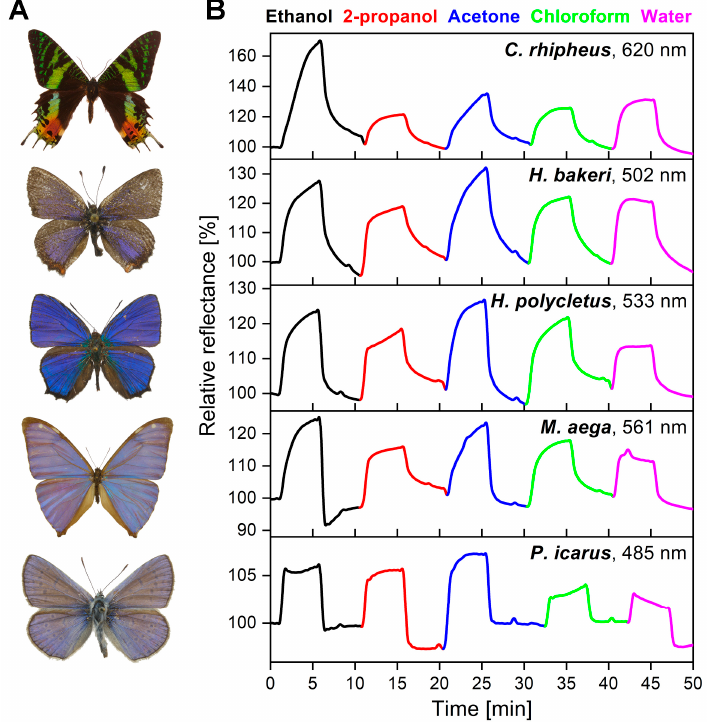
Figure 4. ( A ) Photographs of the investigated male specimens (not to scale). ( B ) Test substances were exposed to the wing-based sensors for 5 min, with 5-min purging in between. The measured time-dependent intensity of the spectral changes was plotted as a function of time. Di ff erent volatile organic compounds (VOCs) are noted by di ff erent colors. Each of the wings showed specific time-dependent optical responses for the five test substances. The nanometer values in the top right corners show the wavelengths of the maximal spectral responses from which the time-dependent signals were generated.